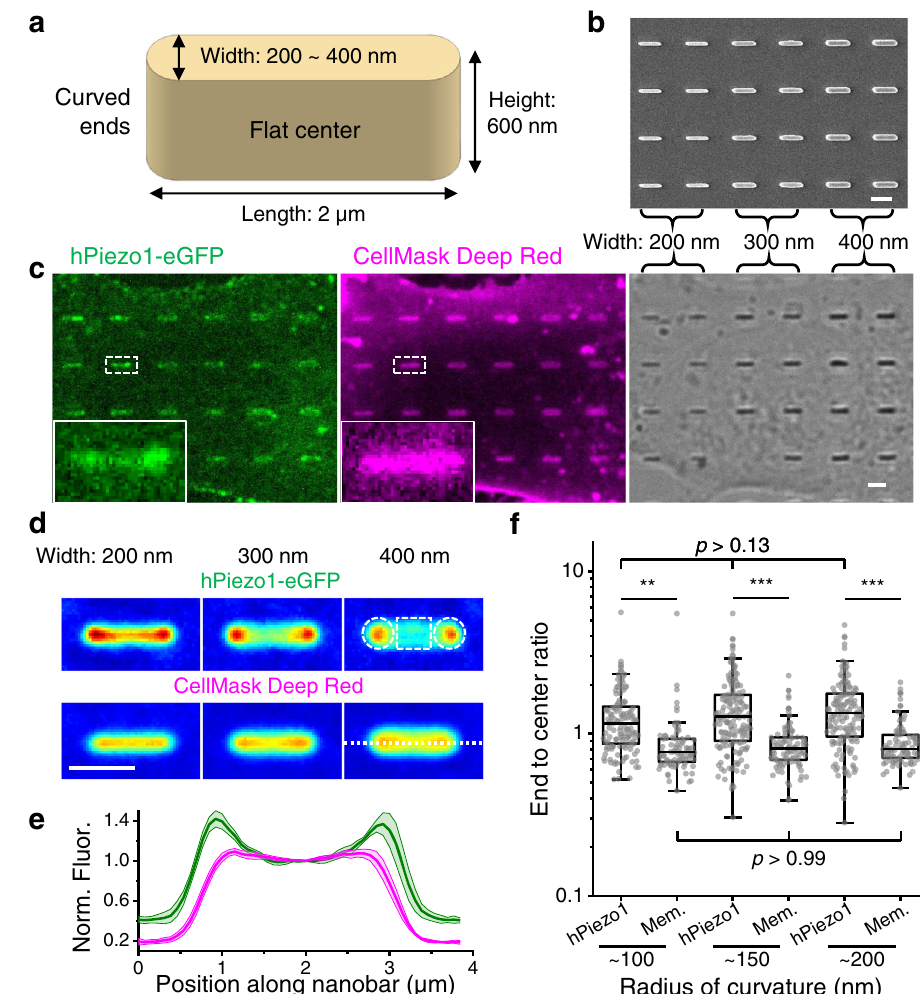
Fig. 3 | Enrichment of Piezo1 towards the ends of nanobars. a Illustration of a nanobar. b Scanning electron microscopy image of the cell culture substrate with 200,300,and400nmwidenanobars. c Arepresentativeimageofcellsculturedon nanobar substrate ( n =8 repeats), expressing hPiezo1-eGFP (left) and stained with CellMaskDeepRed(middle).Thetransmittedlightimageisshownontherightwith the width of nanobars labelled on top. d Averaged fl uorescence images (up: hPiezo1;down:CellMaskDeepRed)ofnanobarswithwidthsof200nm(left; n =141 nanobars); 300nm (middle; n =167 nanobars); 400nm (right; n =155 nanobars). Colormap: blue: low; green: medium; red: high. In the upper right image, the dashed circles and square regions are used to calculate the ‘ end ’ and ‘ center ’